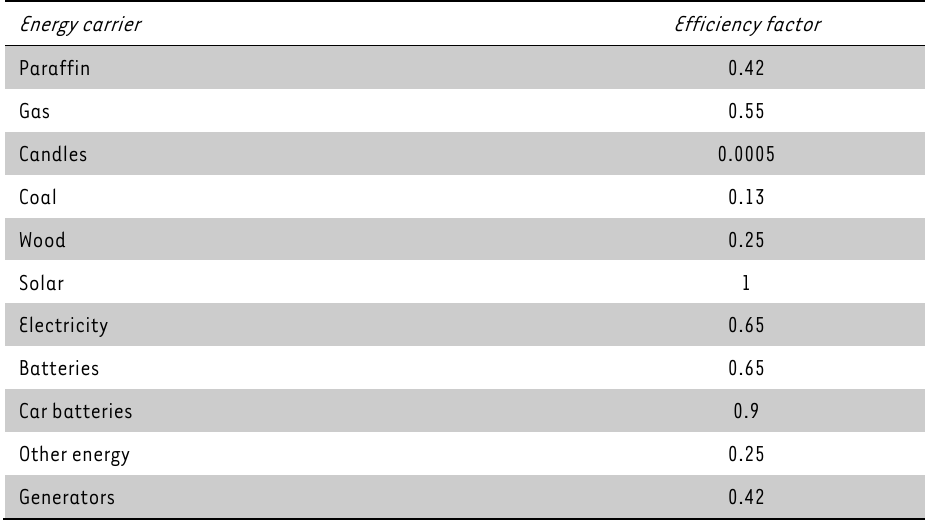
Efficiency conversion factors for each energy carrier